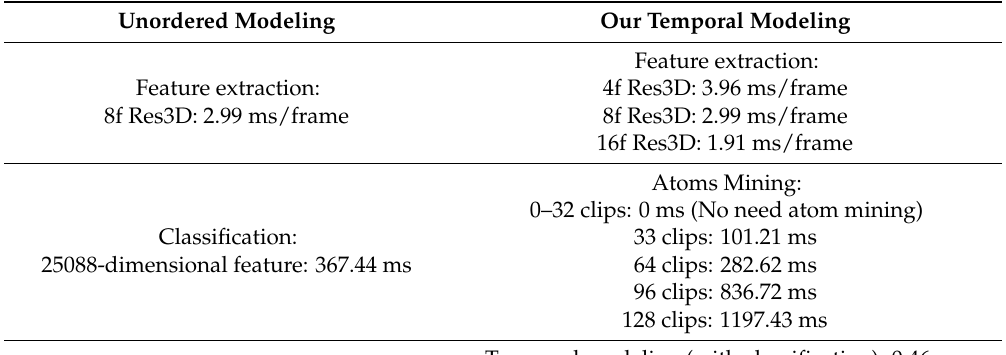
Table 7. Time consumption measurement of each step in the unordered modeling and temporal modeling. Unordered Modeling Our Temporal